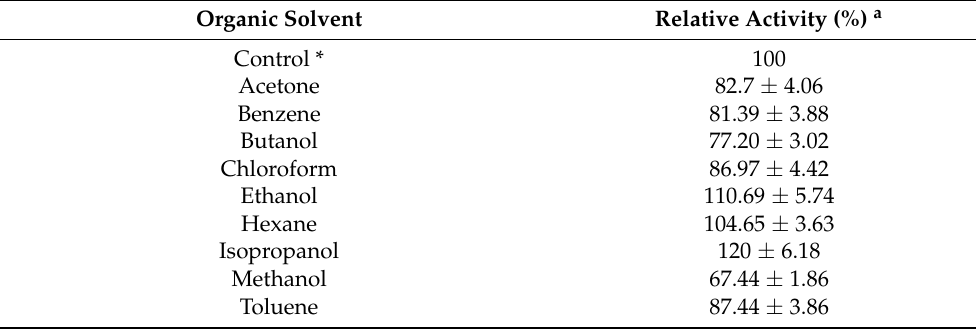
Table 5. Effect of different organic solvents on Beauveria bassiana SAN01 xylanase activity. Organic